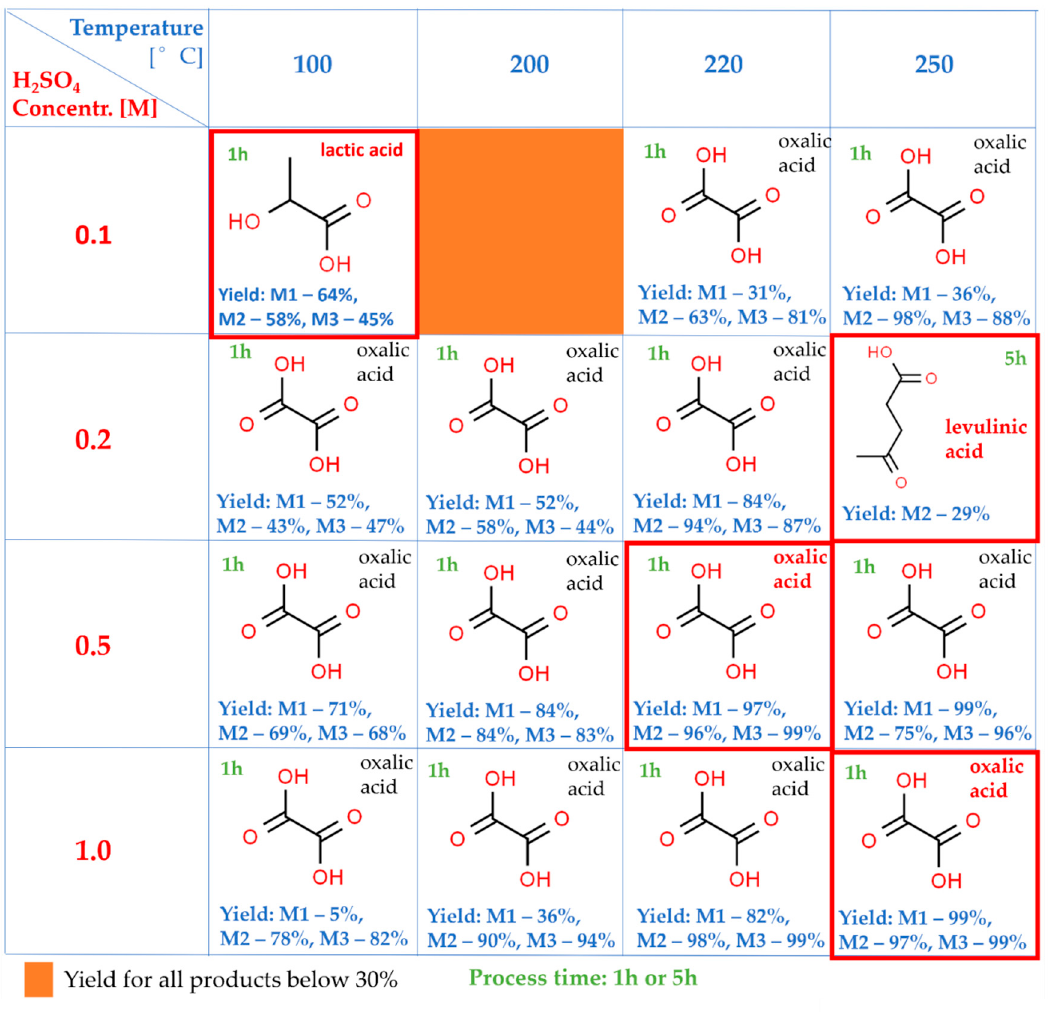
Figure 3. Matrix analysis of optimal process parameters for the production of oxalic, lactic, and levulinic acids as a function of temperature, H 2 SO 4 catalyst concentration, and process time.